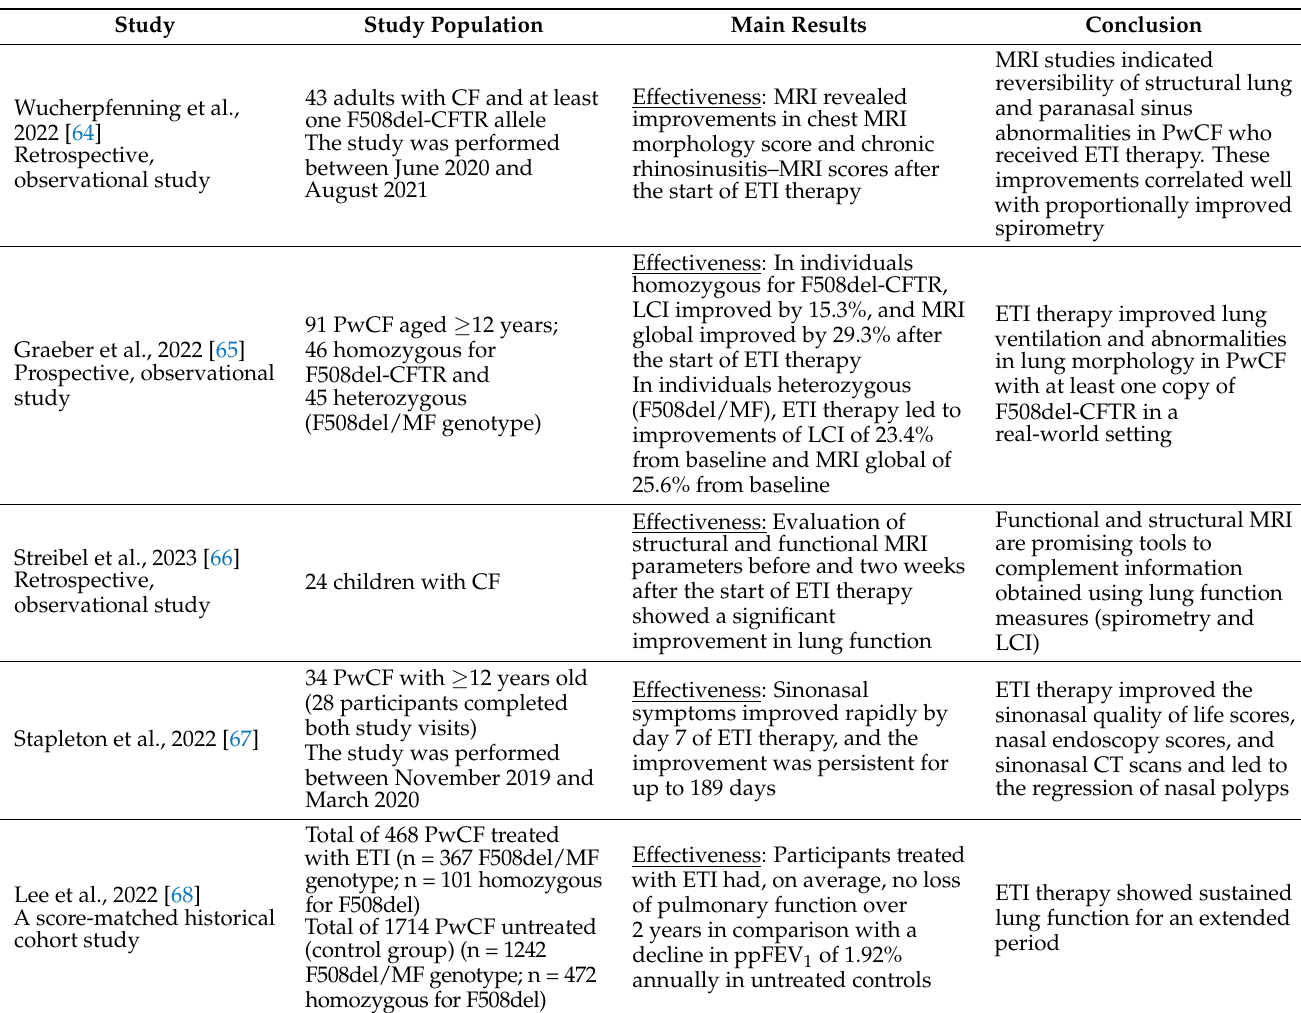
Table 4. Clinical studies assessing the effects of ETI therapy on respiratory symptoms and signs in